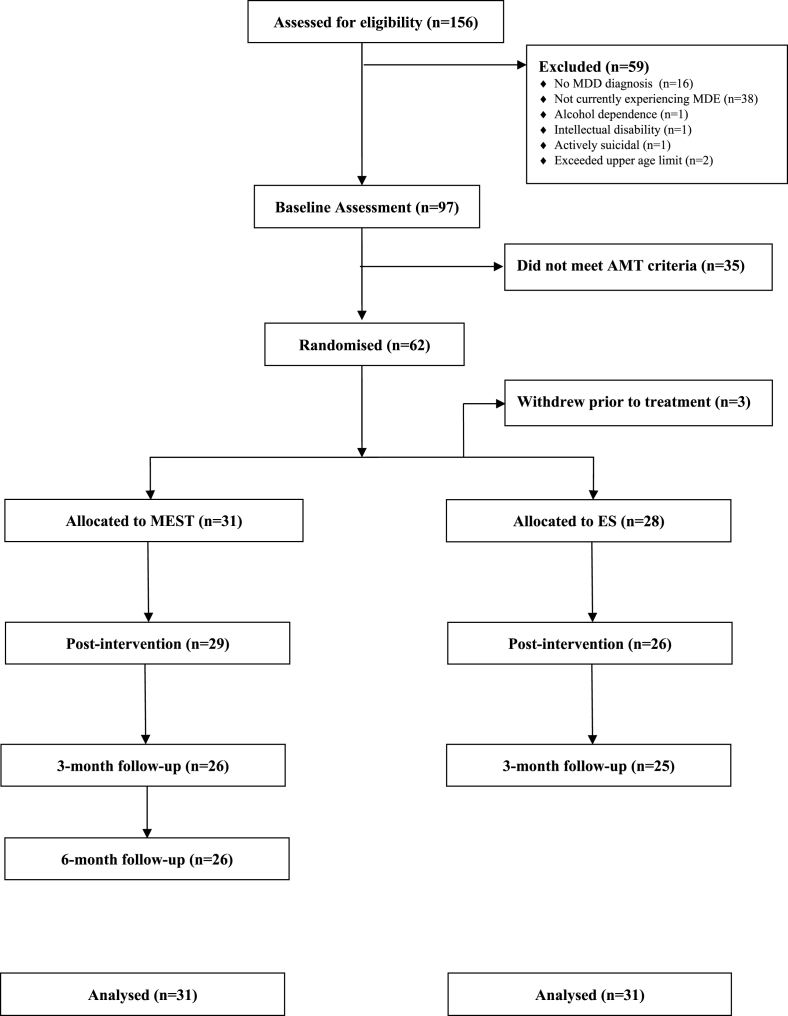
CONSORT flow chart.